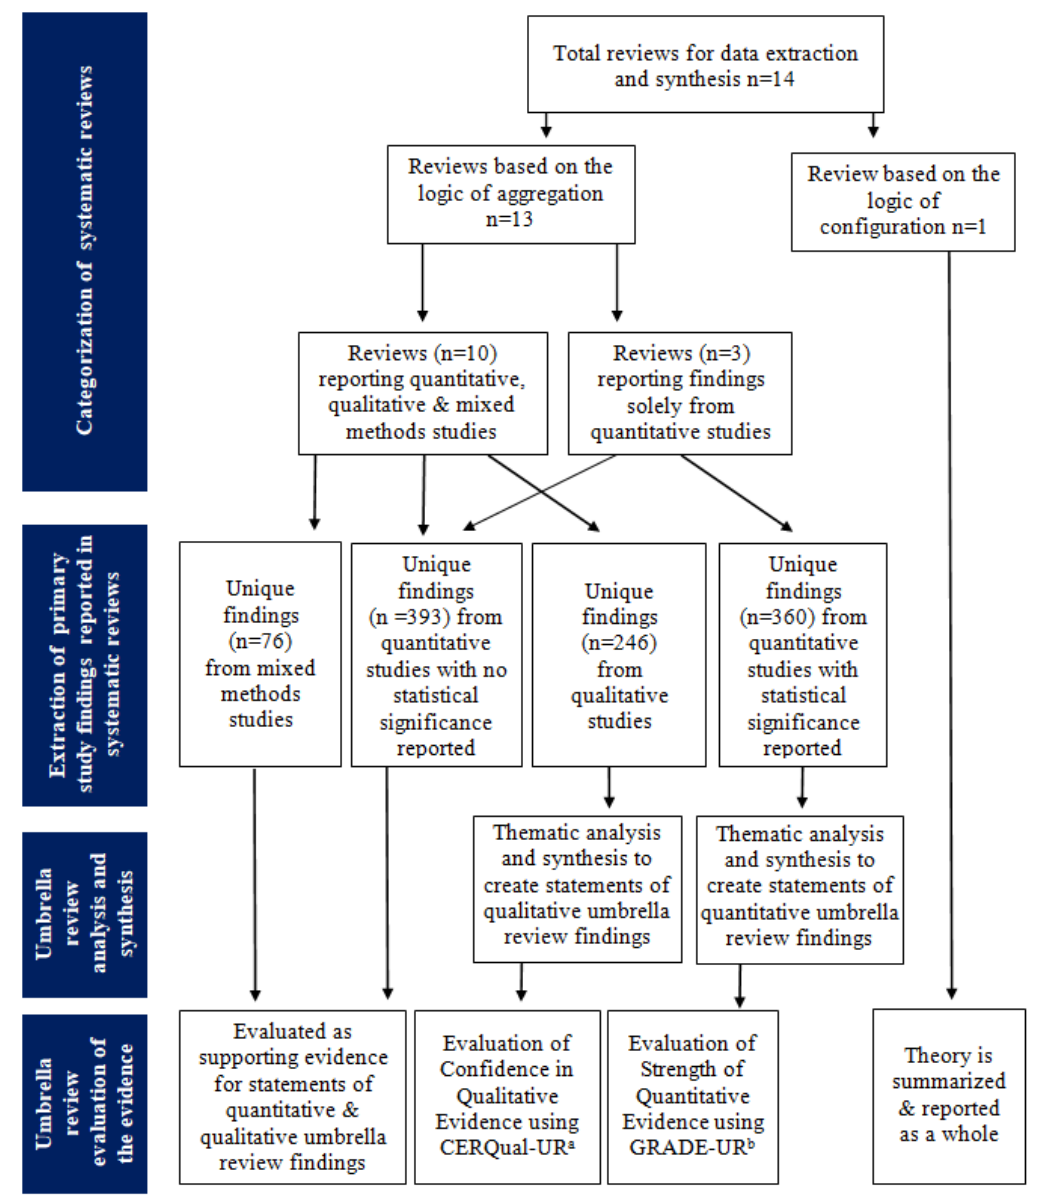
Figure 2. Data Extraction flow